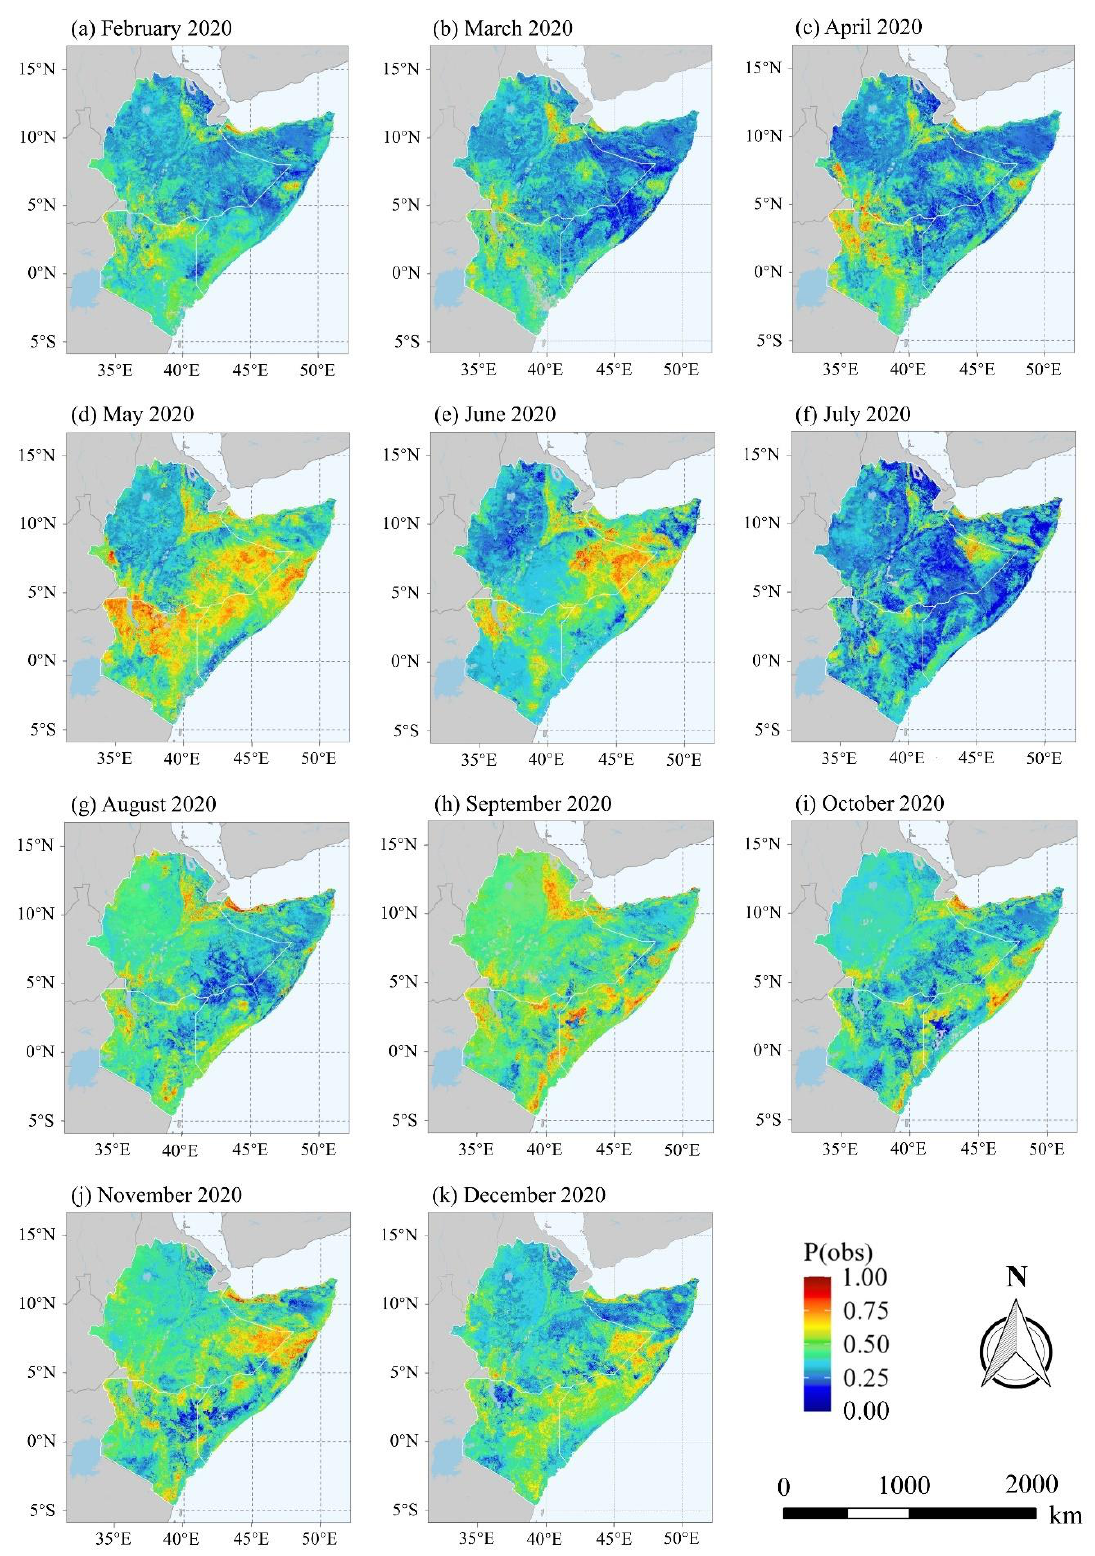
Figure 7. Dynamic predicted probability of observing desert locust band presence in SEK from February 2020 to December 2020.